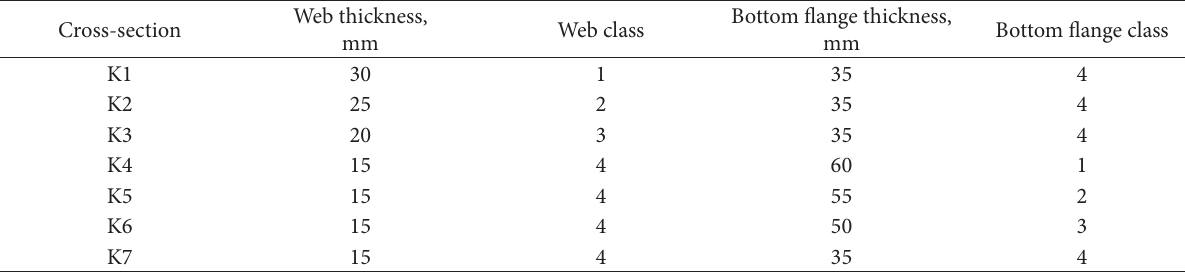
Table 4. Cross-sections under investigation on hogging zone – class 4